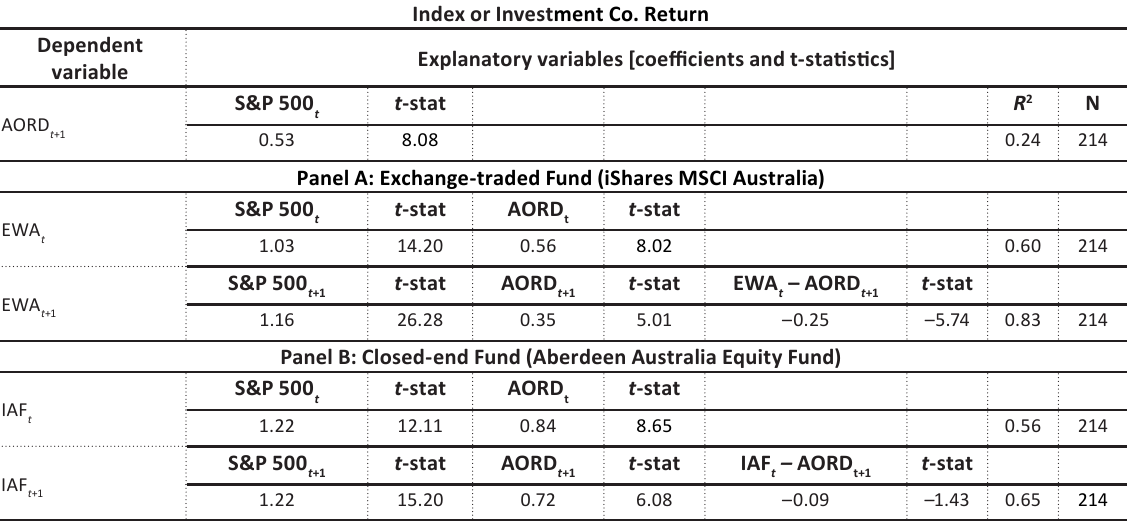
Table 3. Regression estimates for the determinants of Australian equity investment company returns using daily returns for 2006–2010 for the days when the S&P 500 daily return was –1% or lower Index or Investment Co.